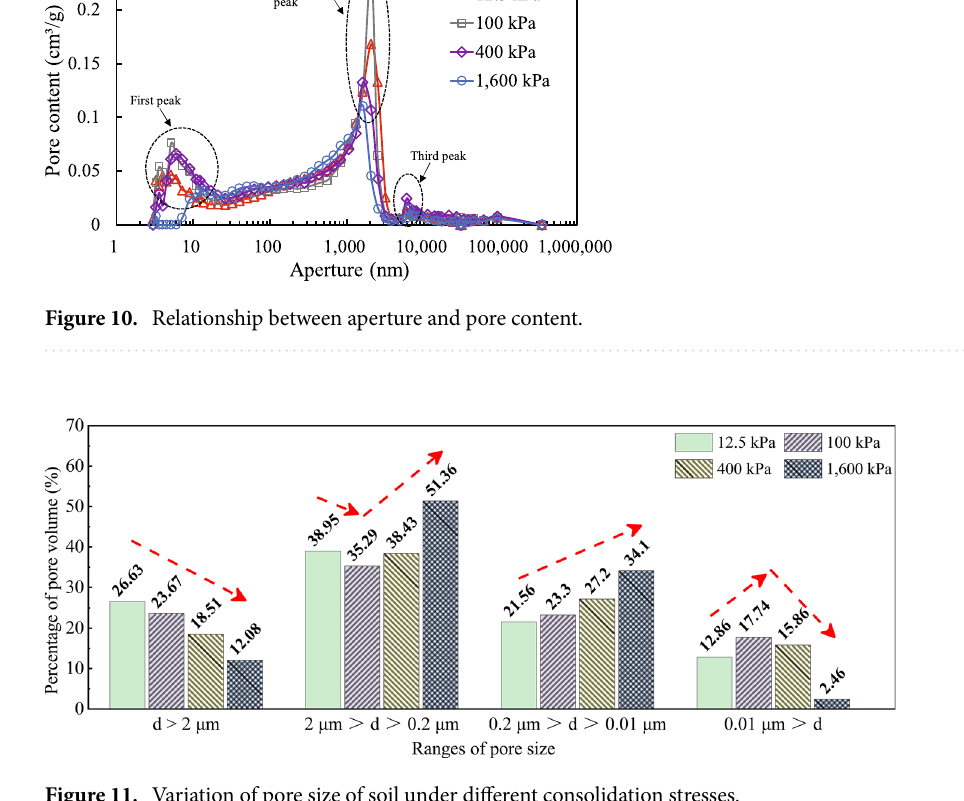
Figure 11. Variation of pore size of soil under different consolidation